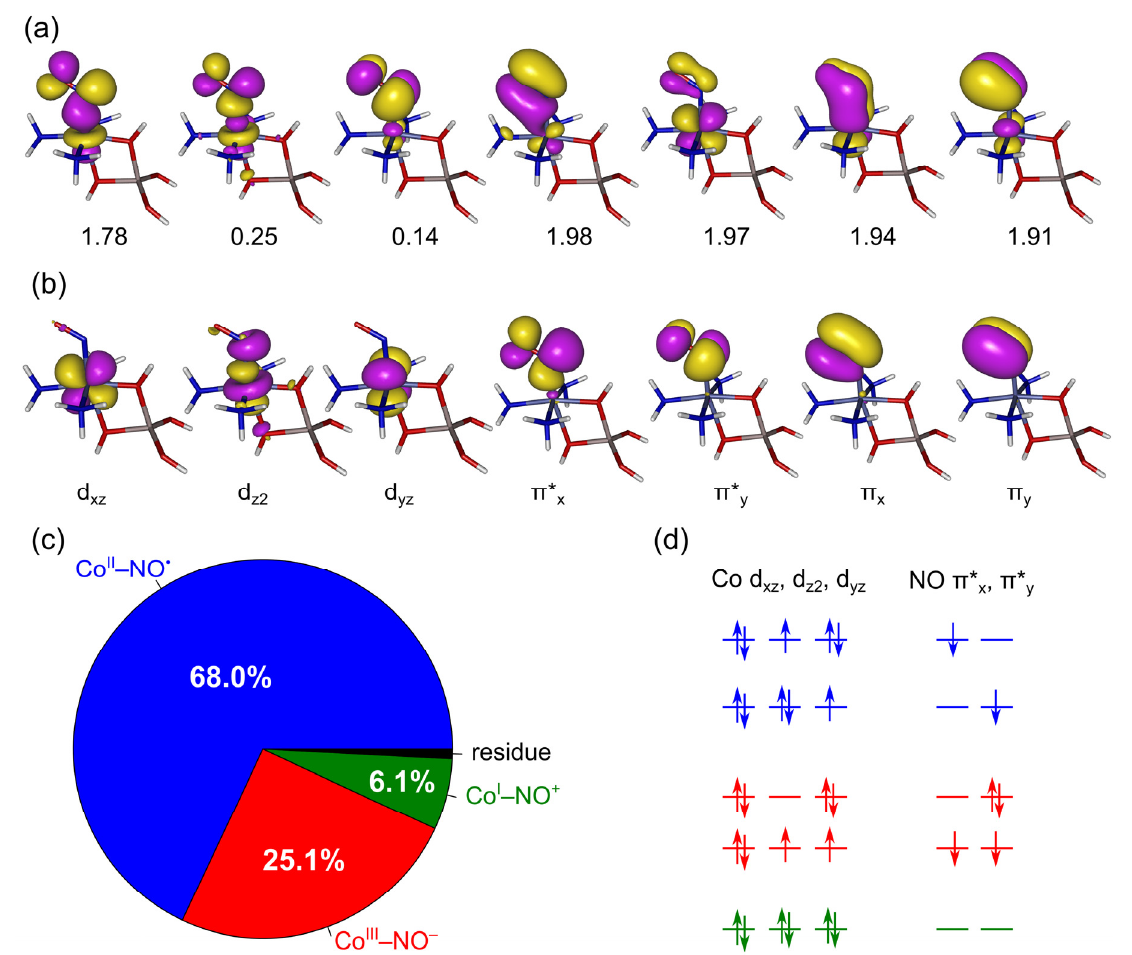
Figure 9. Typical results of CASSCF-VB analysis on the example of [(T1)Cu(NH 3 ) 3 (NO)] + , singlet state (see Ref. [129] for details): ( a ) selected CASSCF(16,14) natural orbitals (delocalized), being linear combinations of the Co 3d and NO π *, π with fractional occupation numbers annotated below; ( b ) selected localized orbitals obtained by unitary transformation of the CASSCF(16,14) natural orbitals along with their qualitative designation as Co d xz , d z2 , d yz and NO π * x,y , π x,y fragment orbitals; ( c ) percentage contributions of the participating resonance structures; ( d ) schematic representation of the most relevant individual electronic configurations in terms of the Co d xz , d z2 , d yz and NO π * x , π * y fragment orbitals (colors correspond to colors used in the pie chart in ( c